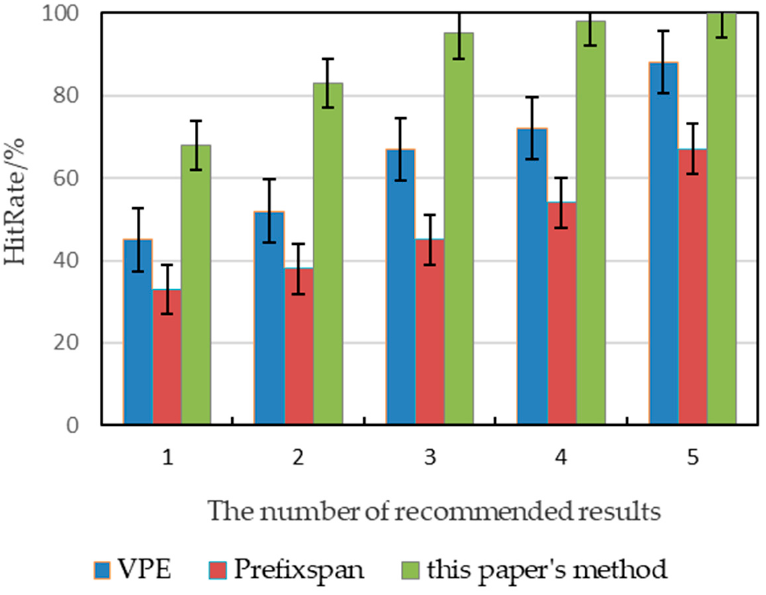
Figure 8. Effectiveness test of the proposed algorithm for the process Figure 8. E ff ectiveness test of the proposed algorithm for the process recommendation.